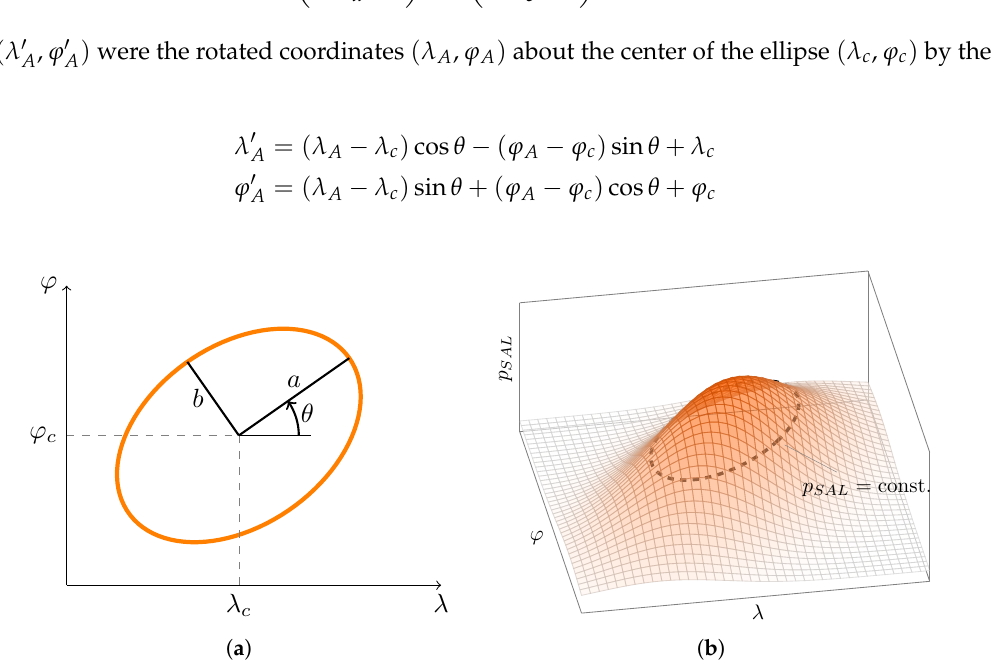
Figure 1. ( a ) Tilted ellipse in the longitude–latitude ( λ - ϕ ) space. ( b ) Probability distribution assigned to a geofenced area, with an elliptical geofence as the line of equal